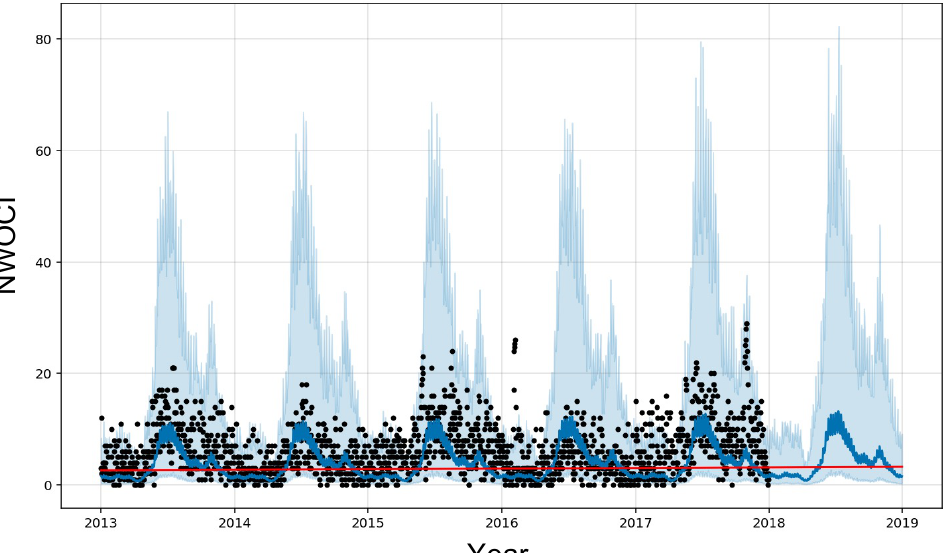
Figure 8. One year forecast result (2018 test data) from Prophet-BU Model for Middlesex county in MA (corresponding NWOCI RMSE value for Middlessex county is 59.6). N.B: The solid blue line shows the average forecast while the solid red line shows the observed trend of NWOCI and the light blue region represents the 80% confidence interval for the forecast uncertainty. Also, the scatter points represent the historical values in the training data